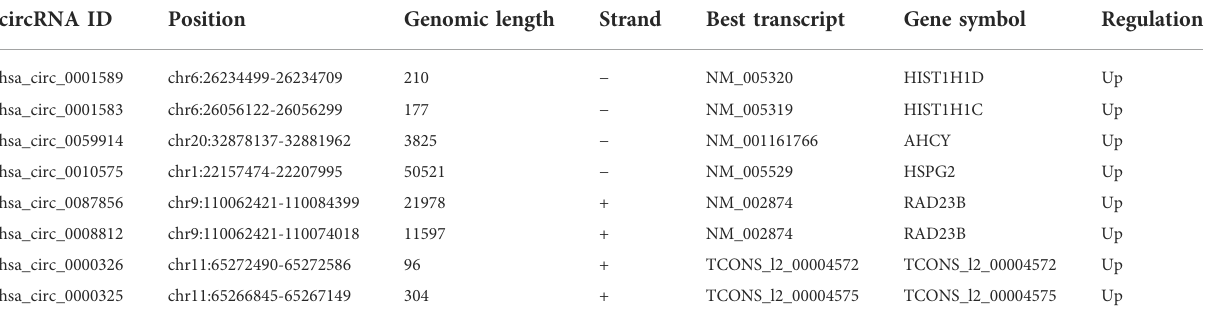
TABLE 3 Basic information of the 8